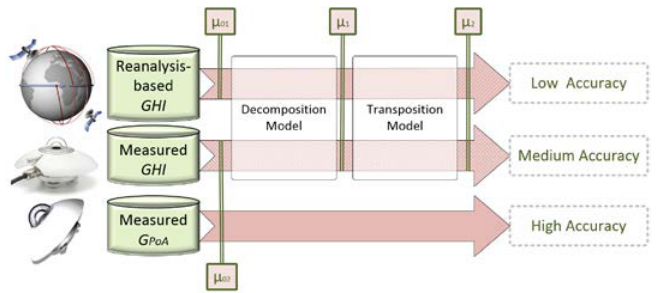
Figure 1. Flowchart for the definition of different levels of irradiance data accuracy at Plane-of-Array (PoA) from measured and modelled data sources.